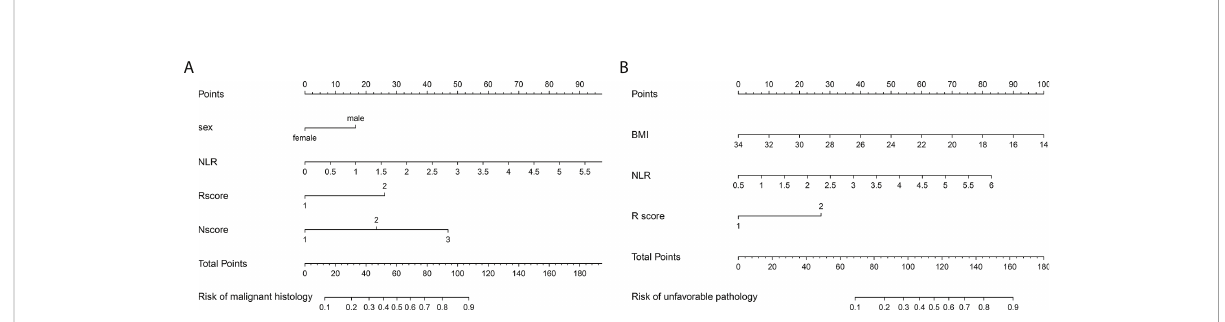
FIGURE 3 The malignant histology-risk nomogram (A) consisted of sex, NLR, R score and N score and the unfavorable pathology-risk nomogram (B) consisted of BMI, NLR and R score were developed to predict malignant and unfavorable pathology features for patients with ERTs. NLR, neutrophil to lymphocyte ratio; BMI, body mass